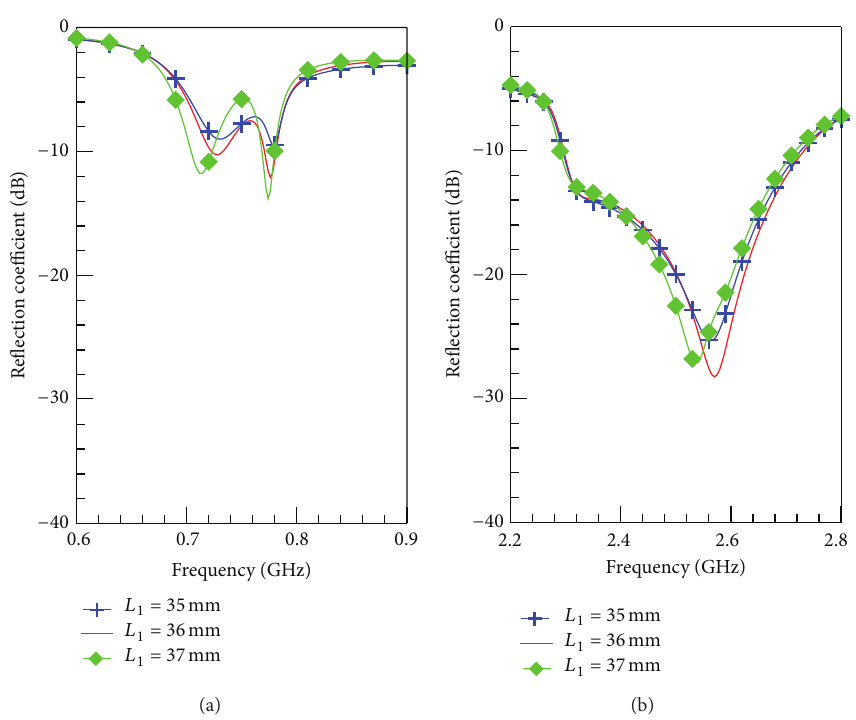
Figure 6: Simulated reflection coefficient of the proposed antenna as the function of 𝐿 1